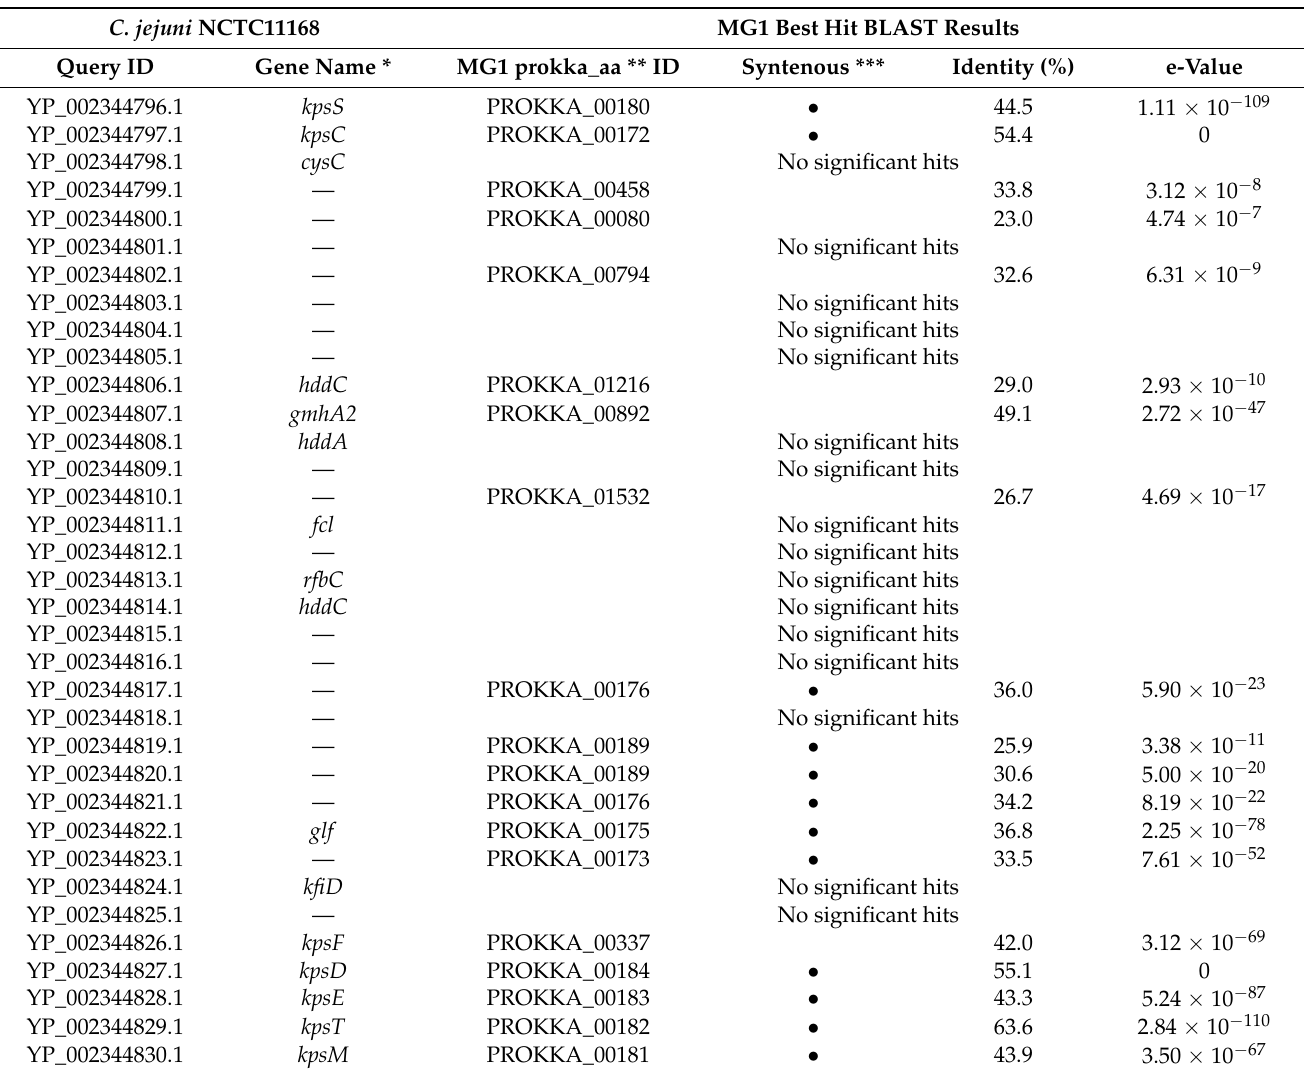
Table 4. Presumptive MG1 capsular polysaccharide loci identified by BLAST analysis of pro- tein